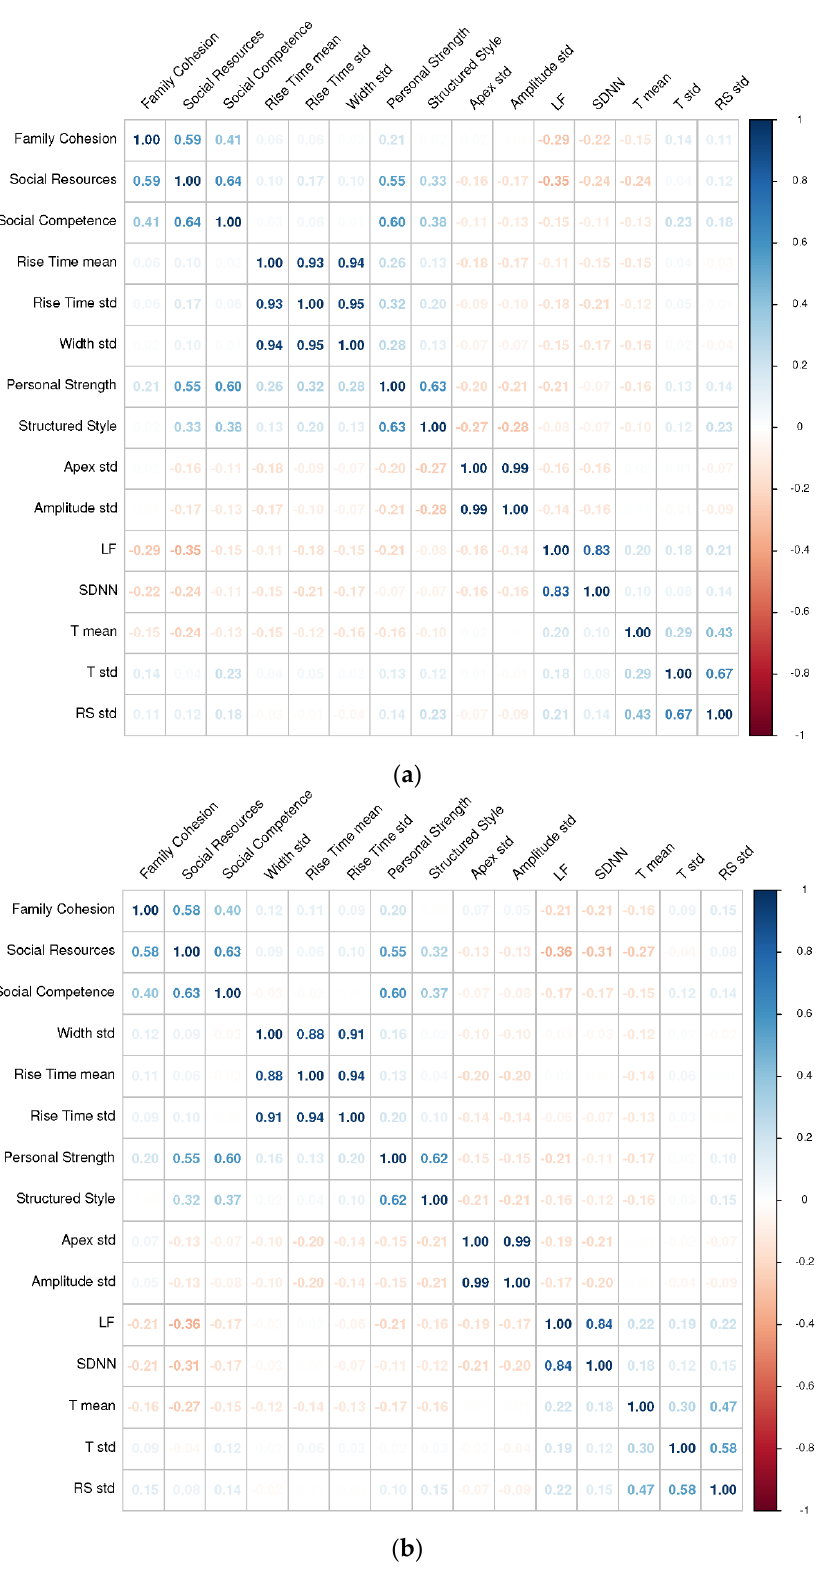
Figure 4. ( a ). The correlations between each RSA score and each physiological feature ( only negative memories ) . Physiological features that were not significantly correlated with any RSA dimensions (i.e., p > 0.05) are excluded from the plot. ( b ). The correlations between each RSA score and each physiological feature ( positive and negative memories ) . Physiological features that were not significantly correlated with any RSA dimensions (i.e., p > 0.05) are excluded from the plot.